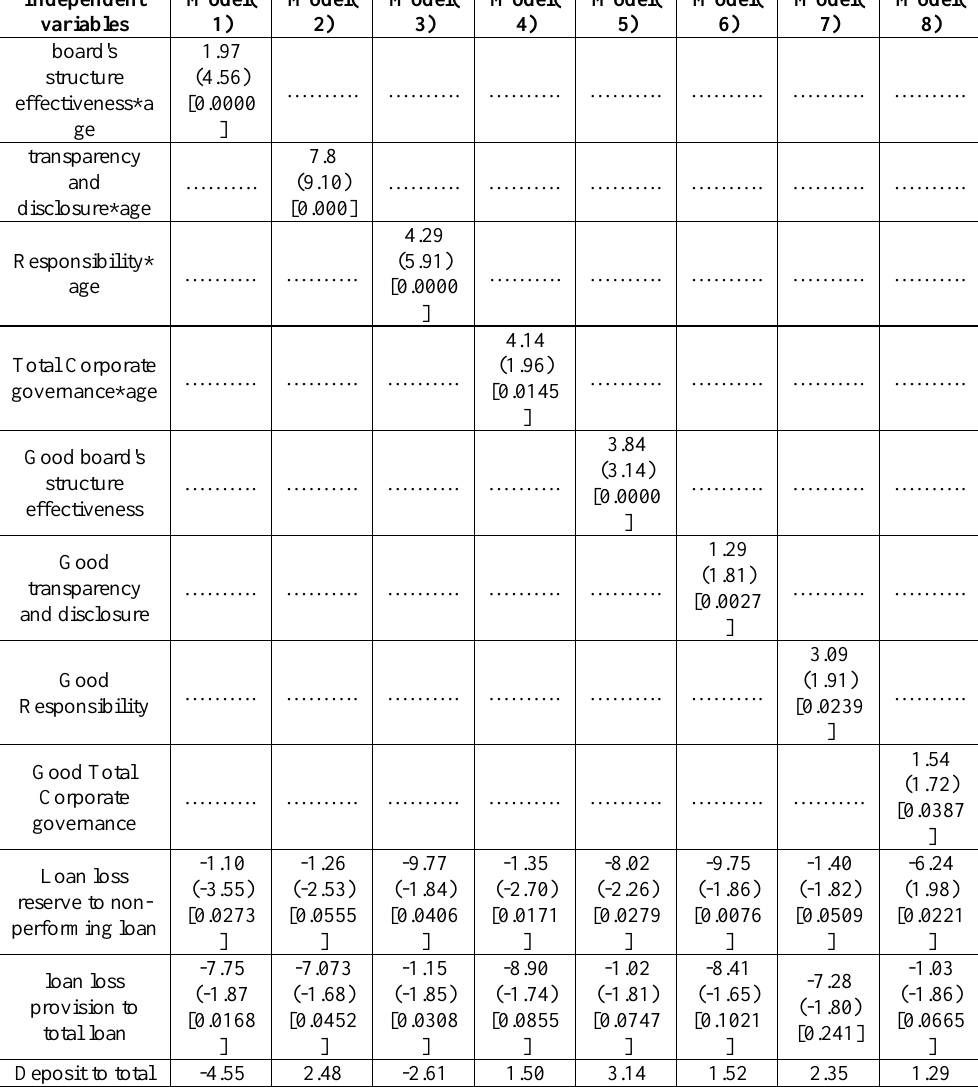
Table 3. Results- Effect of Corporate governance on Banking Economic Value